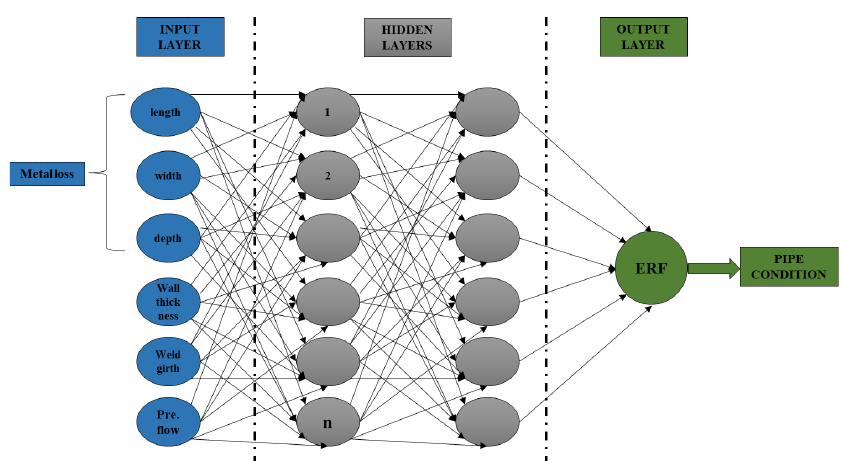
Figure 2. Proposed Neural Network architecture.